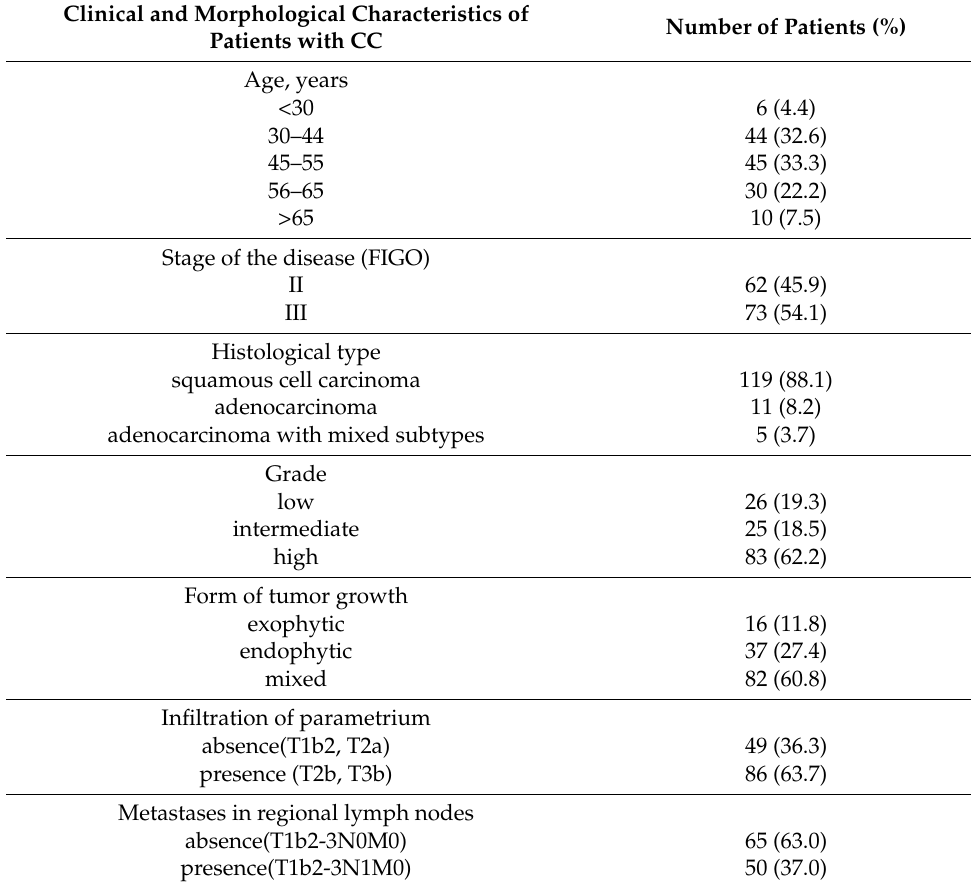
Table 1. Clinical and morphological characteristics of patients with CC ( n = 135). Clinical and Morphological Characteristics